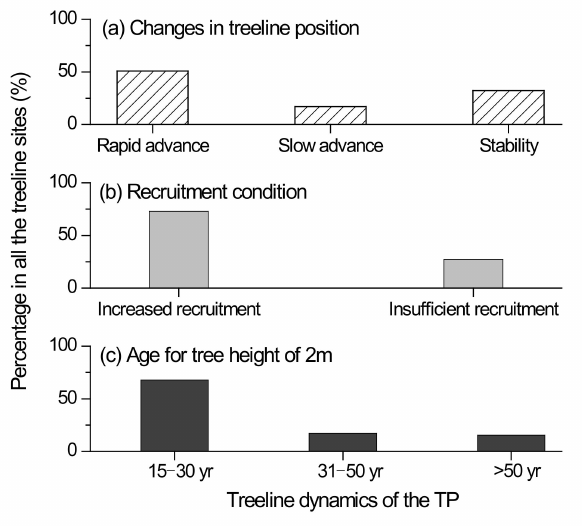
Figure 2. Frequency of treeline sites in the TP showing different treeline advances ( a ); recruitment changes ( b ); height growth rates ( c